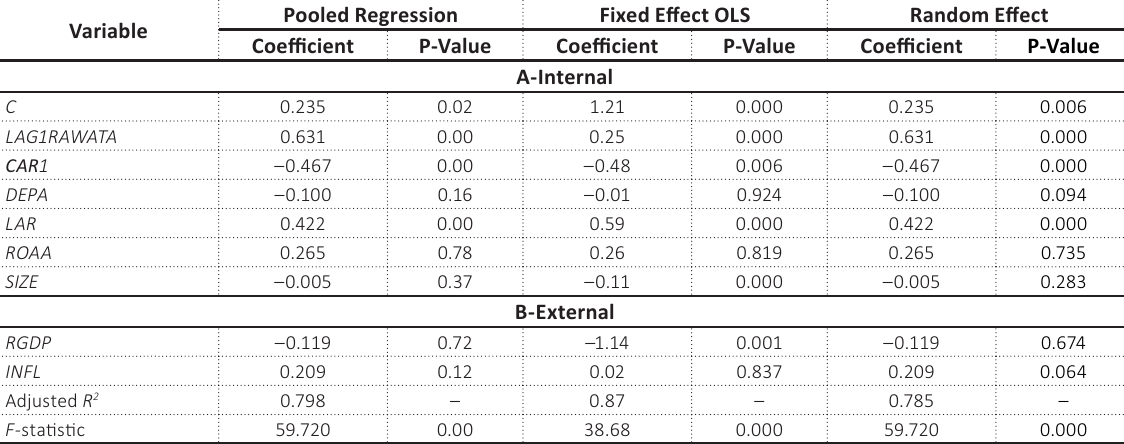
Table 4. Panel regression results of the model